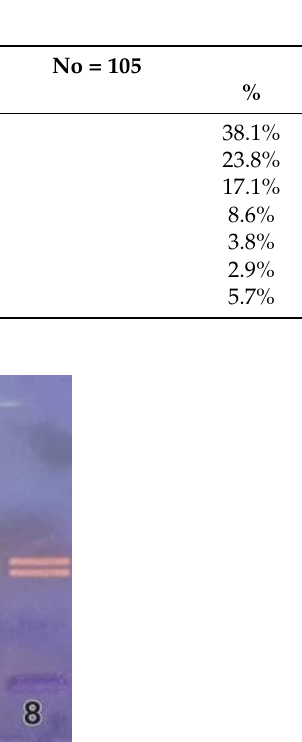
Table 4. Frequency of carbapenemase-encoding genes presence among CRKP isolates.